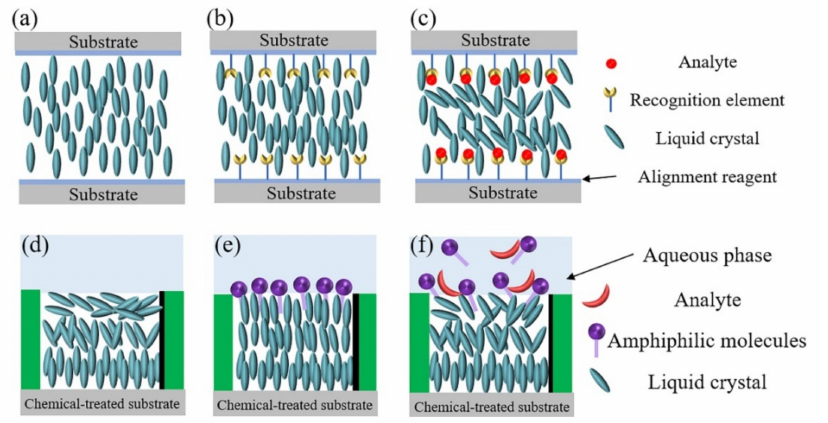
Figure 1. Schematic illustrations of the alignment of LCs on ( a ) alignment reagent-treated substrate, ( b ) recognition element-decorated alignment reagent-treated substrate and ( c ) recognition element- decorated alignment reagent-treated substrate after the addition of analyte. Schematic illustrations of LC-aqueous interface ( d ) without and ( e ) with the assembled amphiphilic molecules. ( f ) The amphiphilic molecules-decorated LC-aqueous interface after the addition of